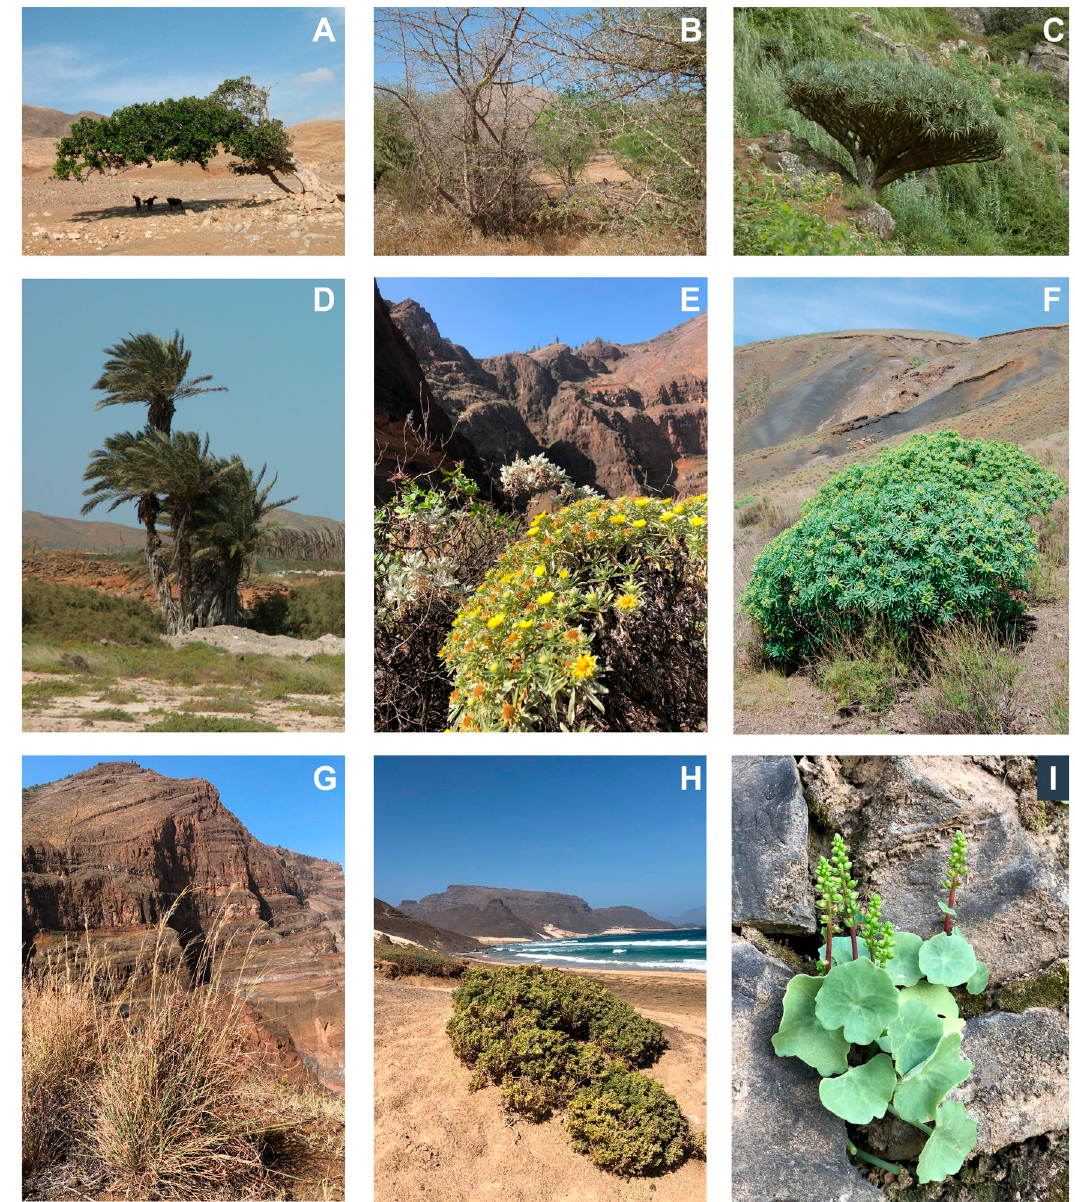
Figure 2. Representative species of some of the main plant communities in Cabo Verde. Woody elements present in woodlands and savannas at lowlands: Ficus sycomorus ( A ), Acacia caboverdeana ( B ), and in mountainous slopes, Dracaena caboverdeana ( C ). Riparian streams, near the coast: Phoenix atlantica ( D ). Shrub communities: Asteriscus vogelii and Artemisia gorgonum ( E ) and Euphorbia tuckeyana ( F ). Perennial grasslands at high altitudes: Hyparrhenia caboverdeana ( G ). Coastal halophytic communities: Tetraena vicentina ( H ). Upland chasmophytic communities: Umbilicus schmidtii ( I ). Photos by M. Cristina Duarte ( A – D ) and Maria Romeiras ( E – I ).